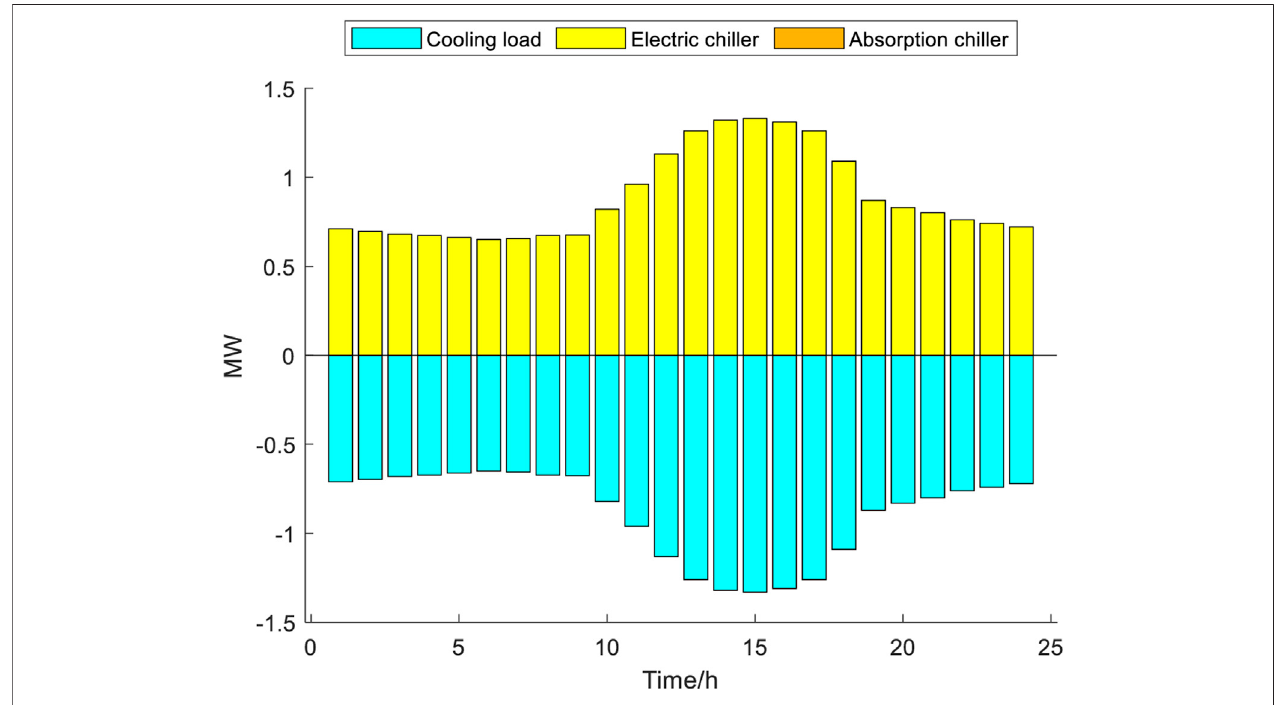
FIGURE 9 | The result of optimal scheduling of cold